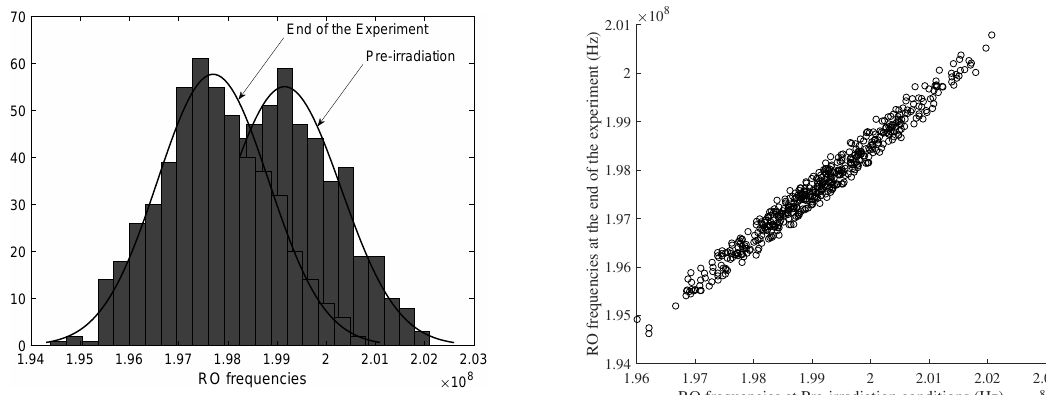
Figure 8. FPGA2 frequency distribution and scatter plot at pre-irradiation conditions and at 500 krad(Si).